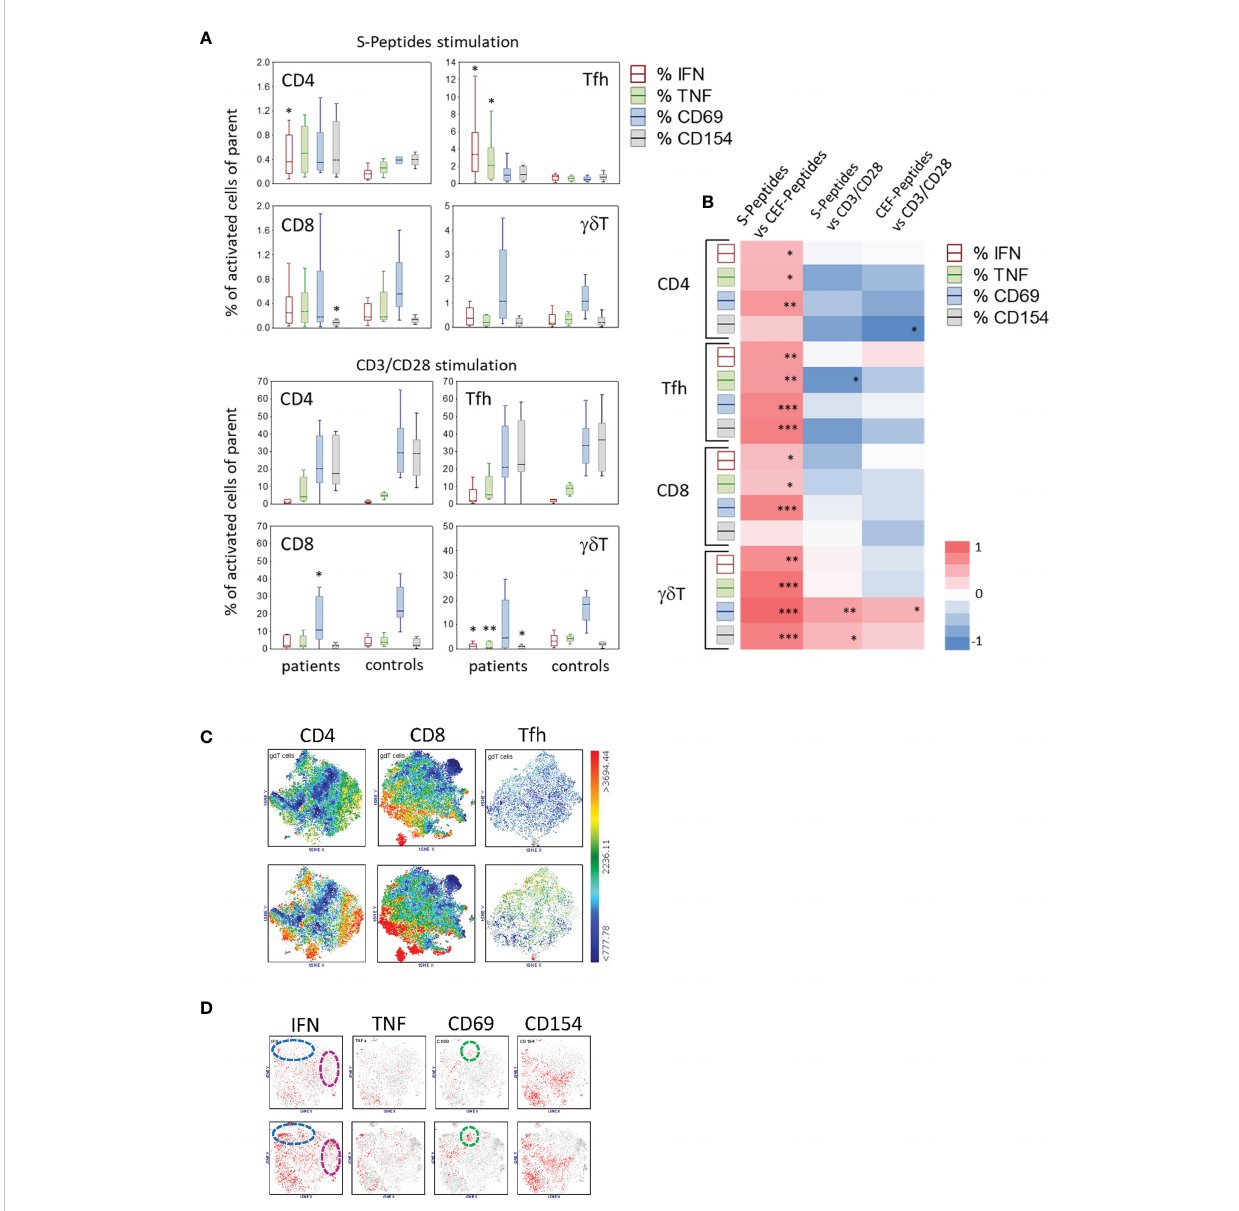
FIGURE 3 Activated T cell subtypes (A) in S-Peptides and CD3/CD28 stimulated samples of patients (N=12#) and controls (N=12) after two vaccine doses. Box plots with median, interquartile range and minimum-to-maximum whiskers show activated T cell subtypes as a percentage of the parent population (CD4, Tfh, CD8, gd T). Cells were identi fi ed after 6 h stimulation of PBMC and intracellular staining of cytokines (IFN, TNF) and activation markers (CD69, CD154) followed by fl ow cytometry. Data analysis with Mann-Whitney U Test, *p<0.05, **p<0.005. Please note the different scaling for better visibility. # Due to the low blood amount, the CD3/CD28 stimulation analysis was not performed in one patient. (B) Correlation between the particularly activated T cell subtypes in patients and controls. Activated T cell subtypes represent the percentage of parent cells producing IFN, TNF, CD69 or CD154 after stimulation with S or CEF-Peptides or CD3/CD28. A heat map presents the correlation coef fi cients (R) gained from the Spearman Rank correlation test, red and blue colors indicate positive and negative correlations, respectively, *p<0.05, **p<0.005, ***p<0.0005. (C) Distribution of gd T cells in the population of CD4, CD8 and Tfh cells as shown by t-SNE analysis color-coded for the expression of TCR gd from blue (low) to red (high) in controls (top) and patients (bottom). (D) t-SNE analysis of activation markers in gd T cells in controls (top) and patients (bottom). Color-coded from grey (<1000) to red (>1000) with dotted circles indicating the area of prominent t-SNE plot